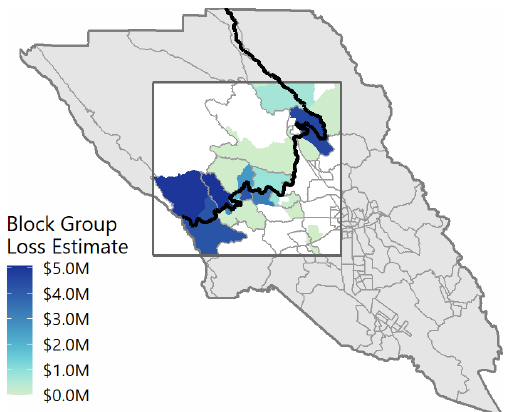
Figure 10. Spatial distribution of PARRA losses. Spatial distribu- tion of mean losses due to the February 2019 event, aggregated to the census block group